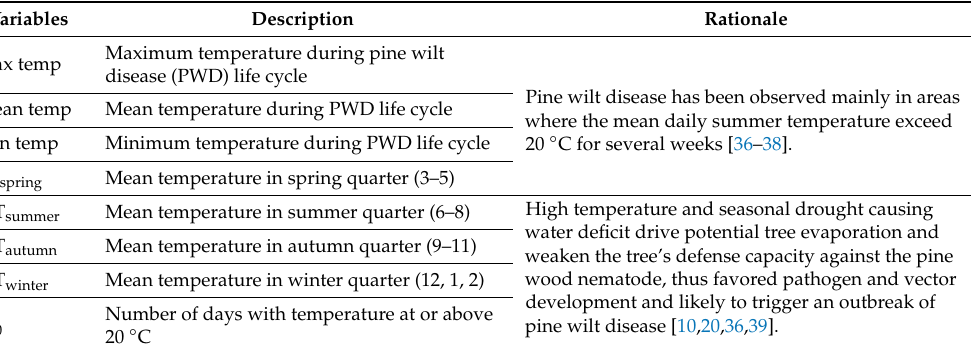
Table 1. Climate and weather variables used to assess their association with the incidence of pine wilt disease outbreaks in the study area from 2006 to